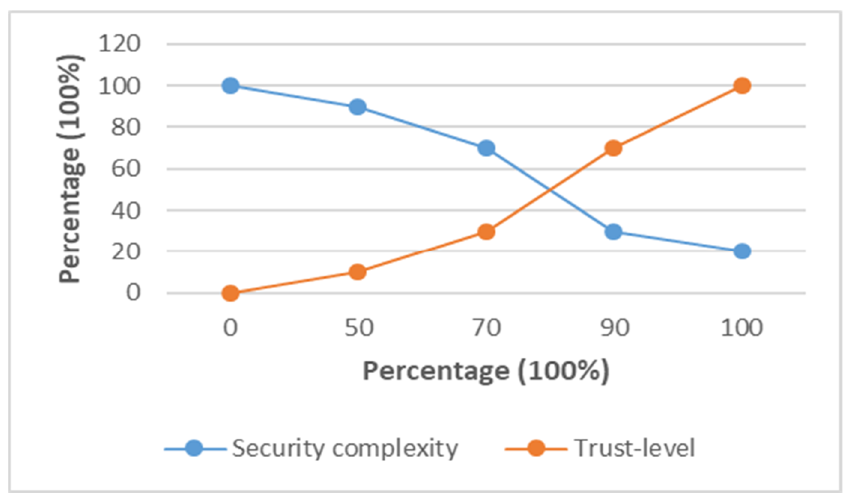
Figure 7. The relationship between the level of trust and the level of security complexity.